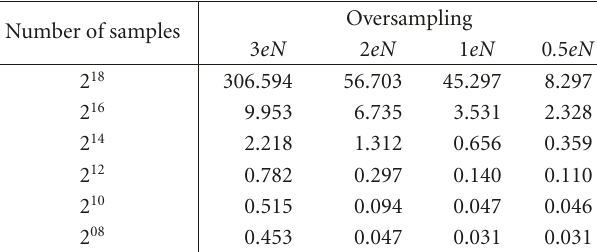
Figure 5: SNR over time for four di ff erent oversampling factors. Test signal: white noise, 16 bits, 44100 Hz, 65536 samples. Table 1: Elapsed times in seconds. Times for complete operation (including loading file from disk).